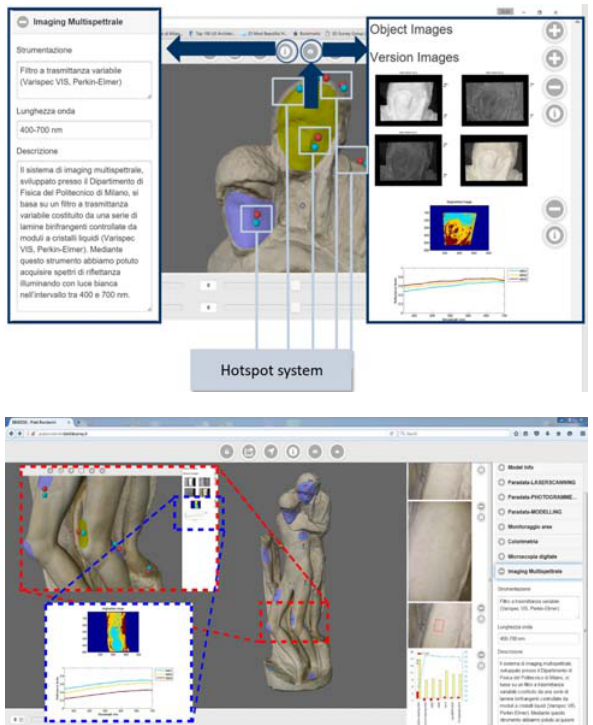
Figure 13. The analyses can be visualised on the 3D model with a hot spot system which reminds to images, graphics, tables and textual